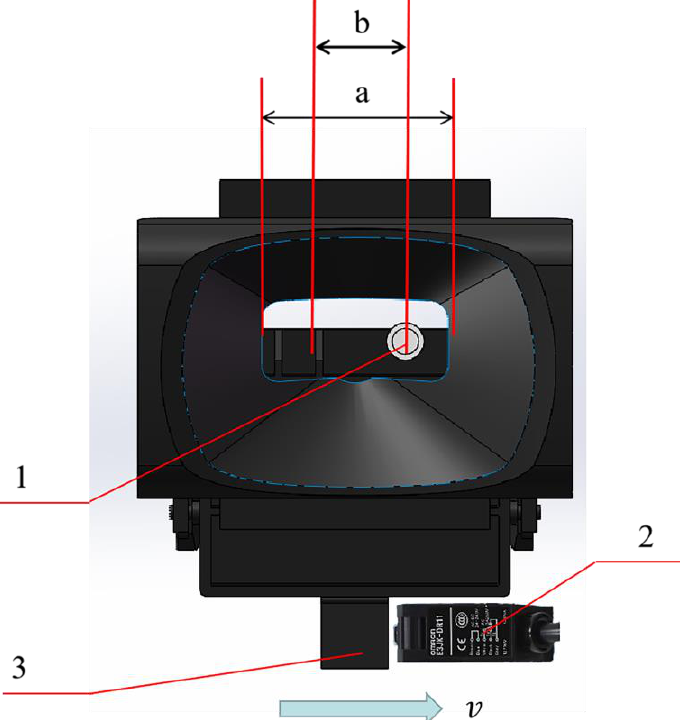
Figure 2. Schematic diagram of fiber position (The arrow is the direction of movement). a: Slit length; b: motion detection effective distance; 1: the optical fiber; 2: photoelectric switch triggering position on fruit cup; 3: photoelectric switch.